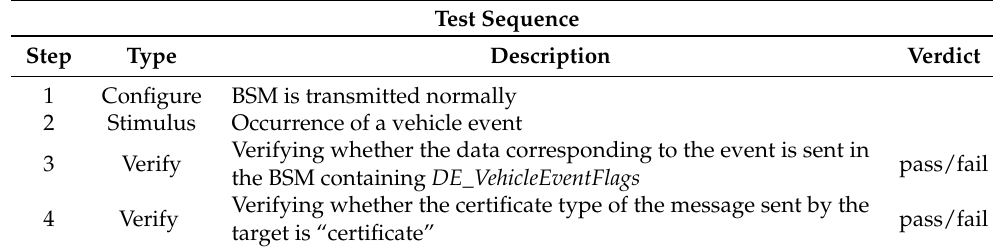
Table 8. Test sequence of Evaluation Scenario